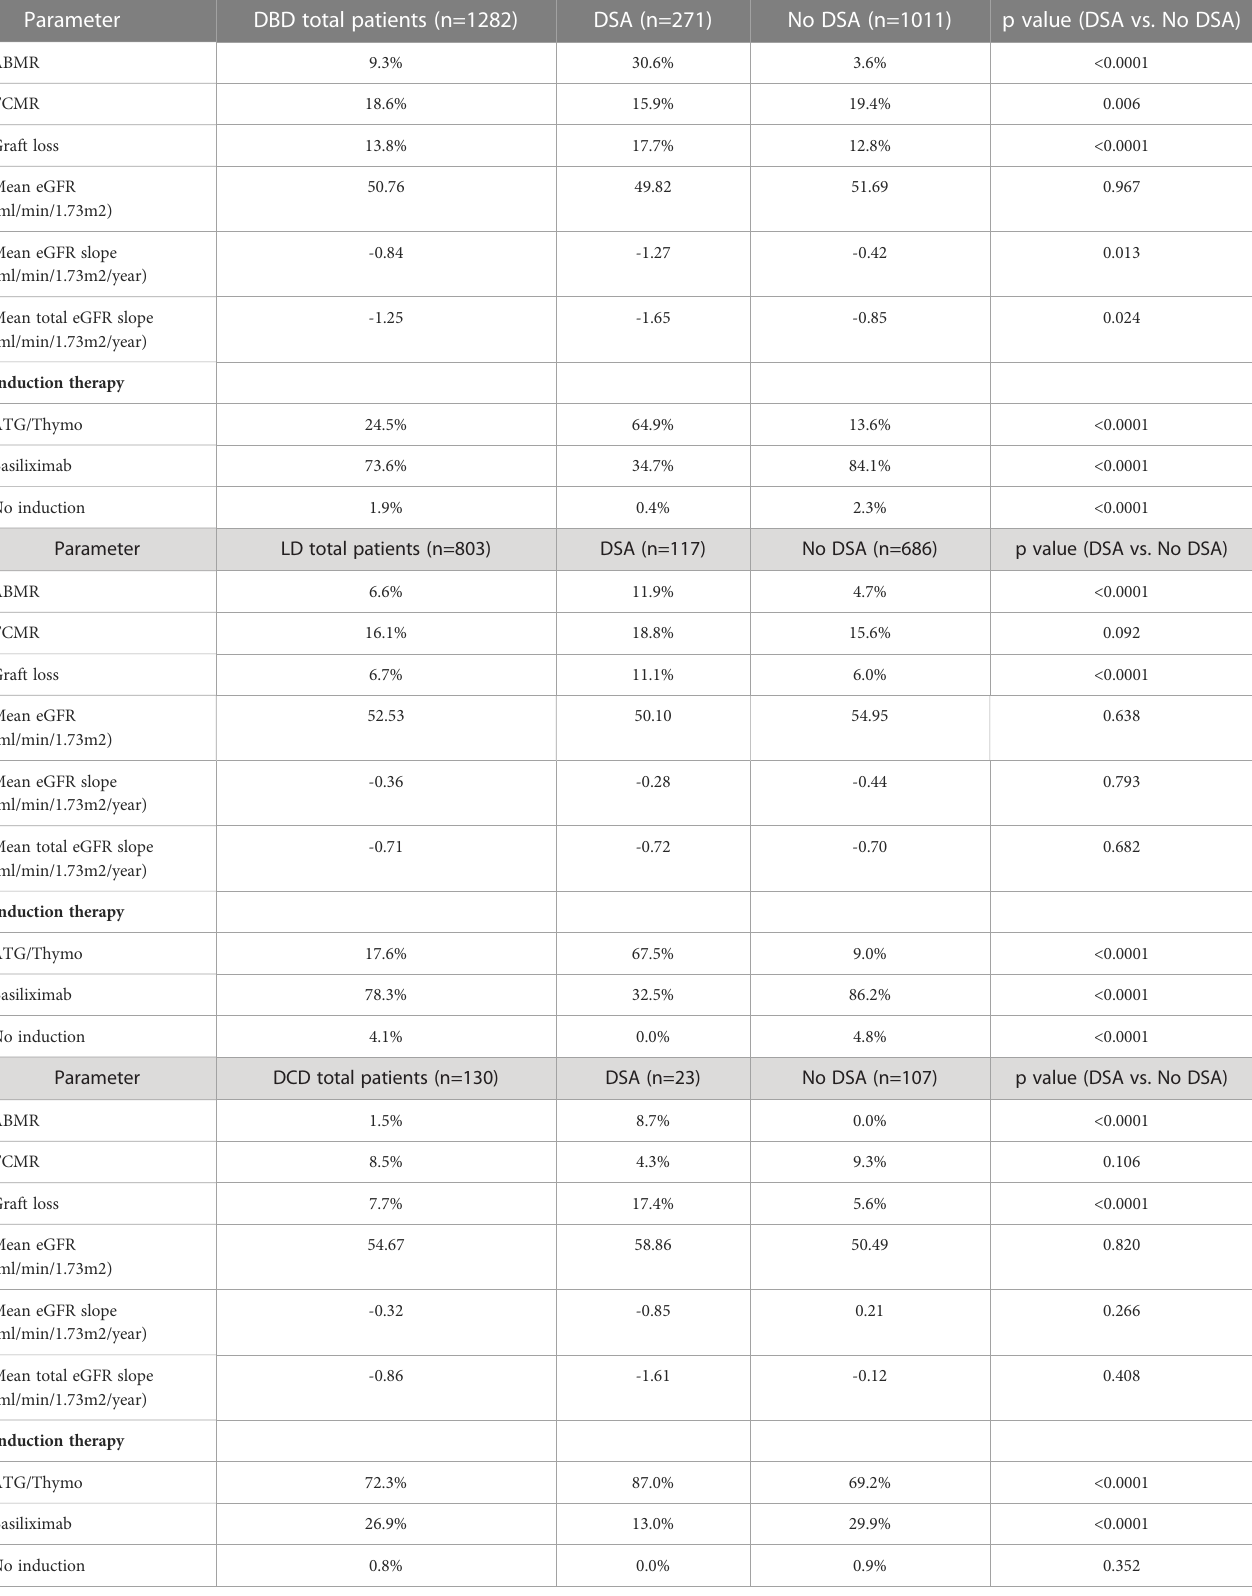
TABLE 2 Summary of the investigated outcomes after kidney transplantation with and withour pre-transplant DSA, and the induction therapy applied on the DSA